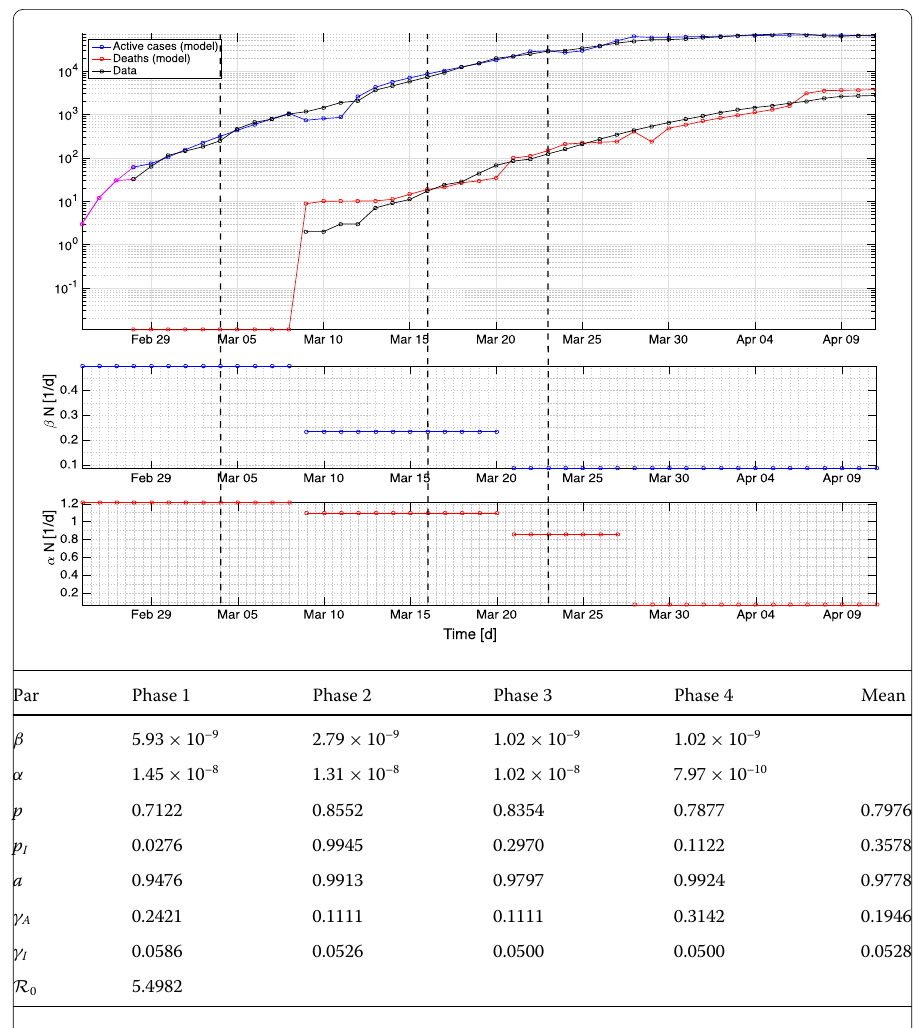
Figure 2 Fitting results using data for Germany. The magenta curve on the top panel shows the initial condition picked only at three points representing three days. Vertical dashed lines encode the commencements of “extraordinary urgency”, restriction on public movement, and contact ban